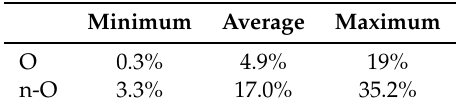
Table 13. Economic cost of the specified pollution as a% of GDP.